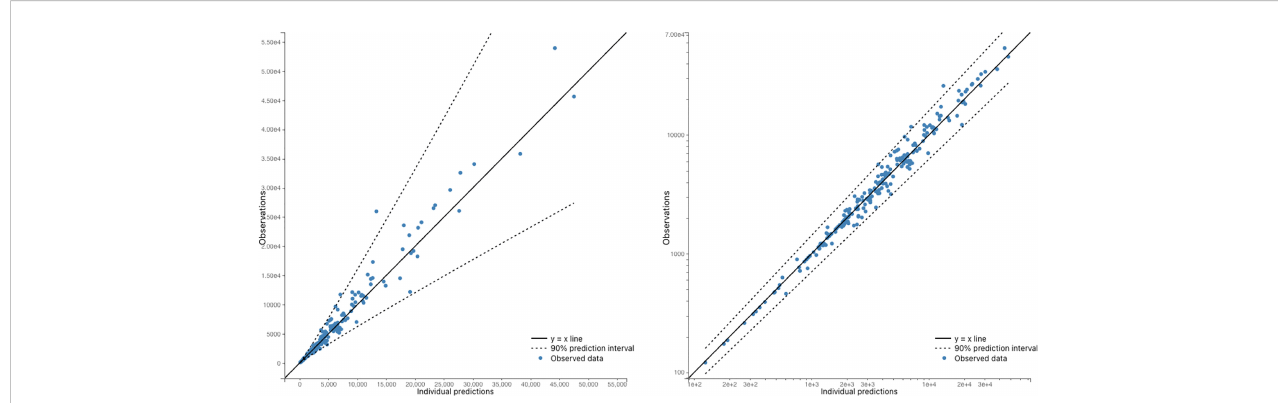
FIGURE 3 Observed antibody levels vs Model 6 predictions. The dots represent the observed data, while the y=x line represents the predicted values. The 95% predicted interval is also plotted, which shows the range within which we would expect 95% of the observations to fall. The plots are presented on both a linear scale (right) and a log-log scale (left). Overall, the fi gure suggests that the model predictions are in good agreement with the observed data, as the dots fall within the predicted interval for the majority of the data